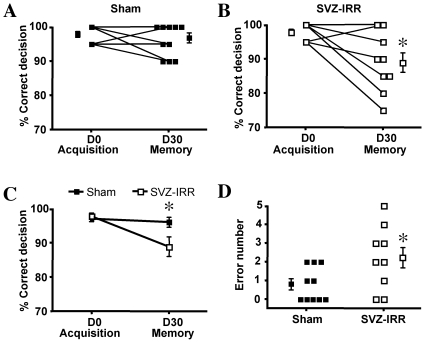
Impaired long-term memory in irradiated mice.Mice underwent 8 blocks of 20 trials every day for 4 days, to train them to distinguish between 1% anisole (rewarded odorant) and 1% cineole (non-rewarded odorant). Mice were tested on the same task after a rest period of one month, in one block of 20 trials, but with no reward given for a correct response. Representative results for experiments performed in triplicate are shown. (A–C) Mean values (%) for correct responses in the last block of training (acquisition) and in the first block of testing (memory test) are shown for each sham-treated (A) and irradiated mouse (B) and for all mice (C). (D) Means of errors in trials 1 to 20 of the memory test session. Two-way ANOVA followed by unpaired or paired Student's t tests, as appropriate; * p<0.05 (n = 9–10).